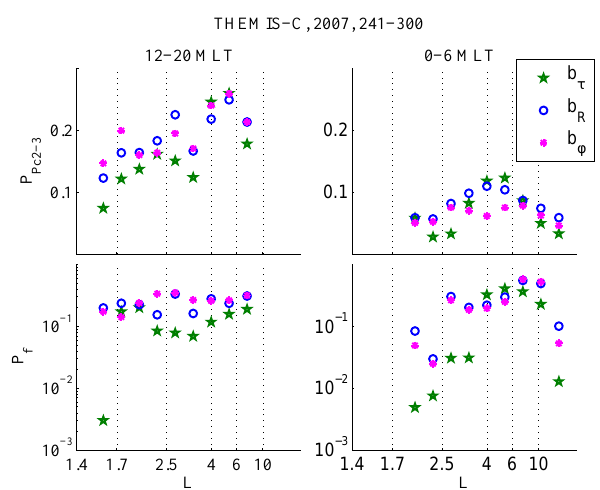
Figure 10. L distribution of the occurrence rate (upper panel) and PSD (bottom panel) for THEMIS-C Pc2-3 in two MLT sectors over 2 months in 2007. Three components are given by different markers and colors.